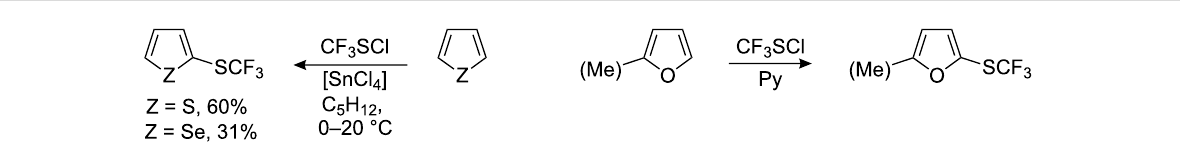
Scheme 17: Reactions of furan, thiophene and selenophene with CF 3 SCl.